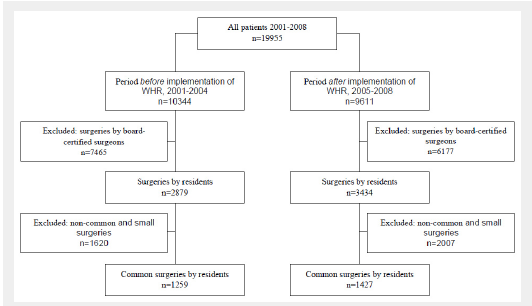
Study design. WHR: work-hour restrictions; non-common surgeries: mammary and thoracic operations, large abdominal and vessel surgeries, surgeries of the genitourinary system, treatment of hand injuries; small surgeries: excision of lymphnodes, metal removals, fracture fixations with Kirschner wires, small amputations, operations on tendons and ligaments and arthroscopies; common surgeries: herniotomy, cholecystectomy, appendectomy, thyroid surgery, proctological interventions, varicose vein operations, colorectal and small intestine surgery, and fracture fixation without Kirschner wire.